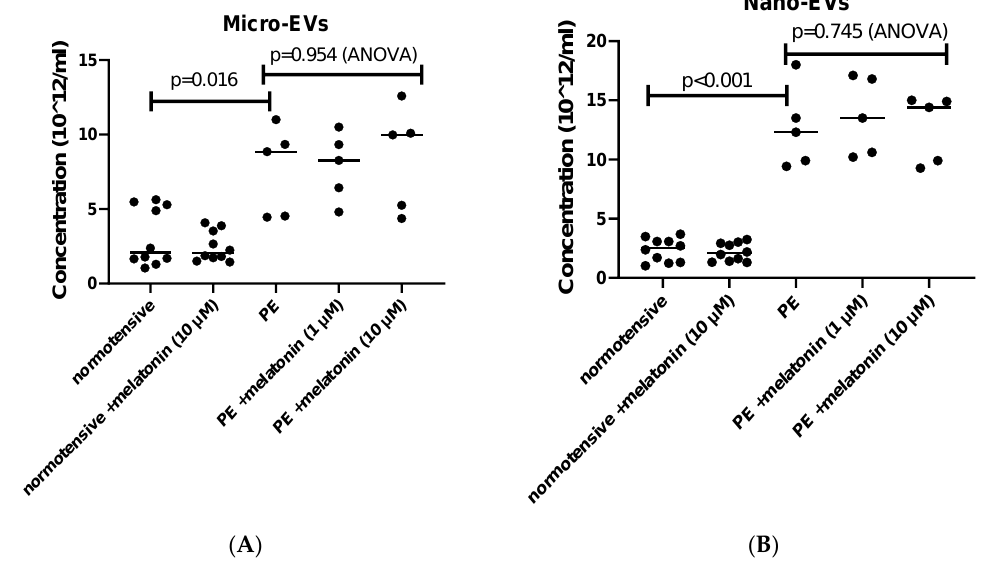
Figure 1. The numbers of micro- ( A ) or nano-EVs ( B ) extruded from preeclamptic placentae (PE) was quantified by NTA, and the statistical analyses were assessed with an ANOVA test or a Mann–Whitney U-test, when appropriate.